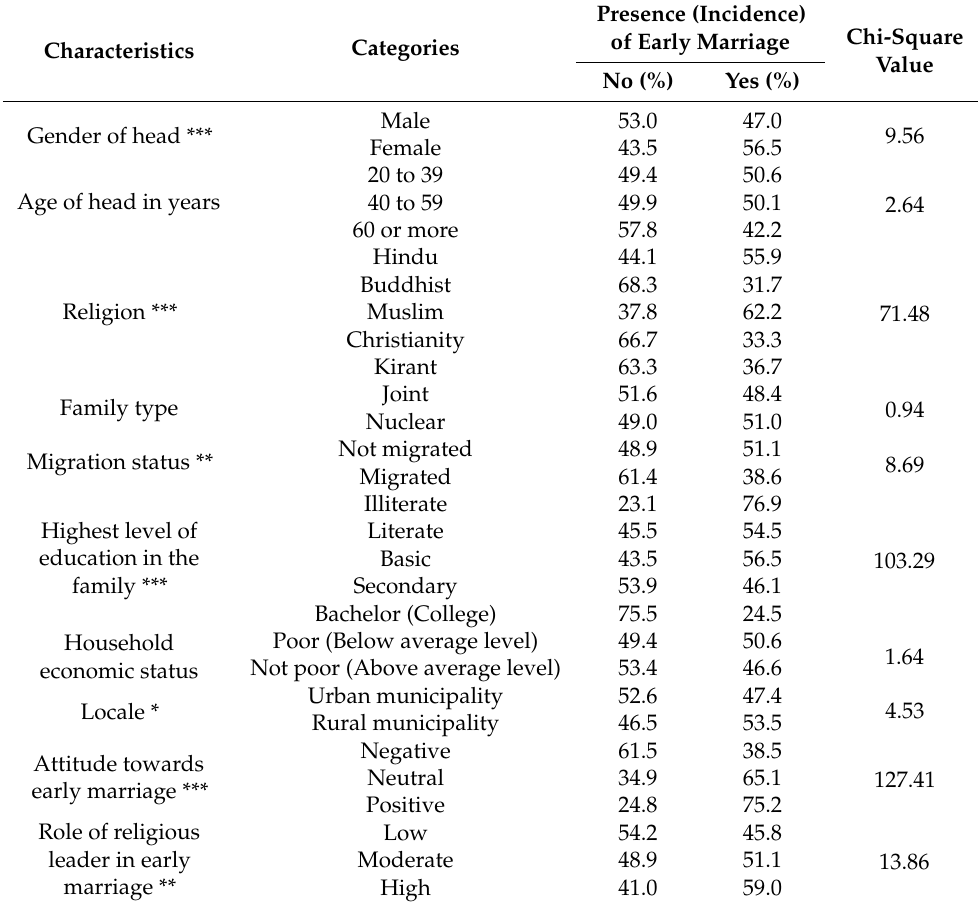
Table 2. Early Marriage due to Socio-demographic and Related Characteristics.